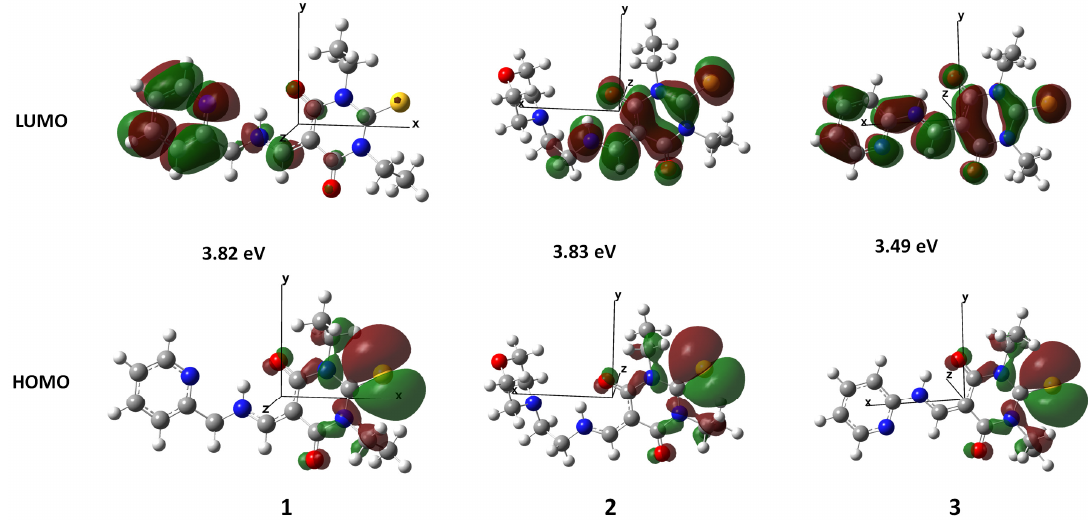
Figure 10. HOMO and LUMO molecular orbitals in 1 – 3 with band gap in each case.